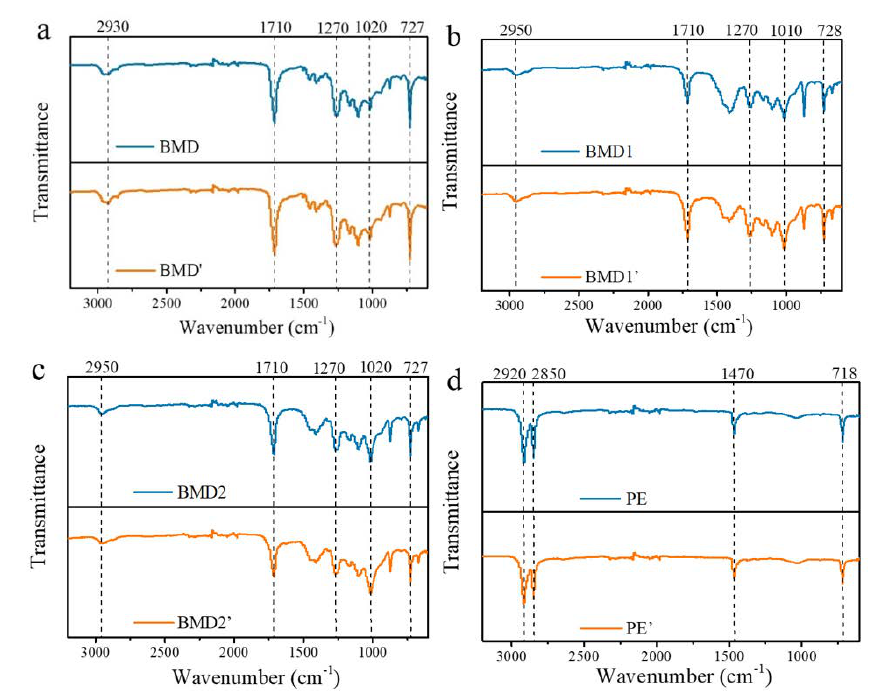
Figure 2. FTIR spectra of films before (( a ) BDM, ( b ) BDM1, ( c ) BDM2, ( d ) PE) and after mulching